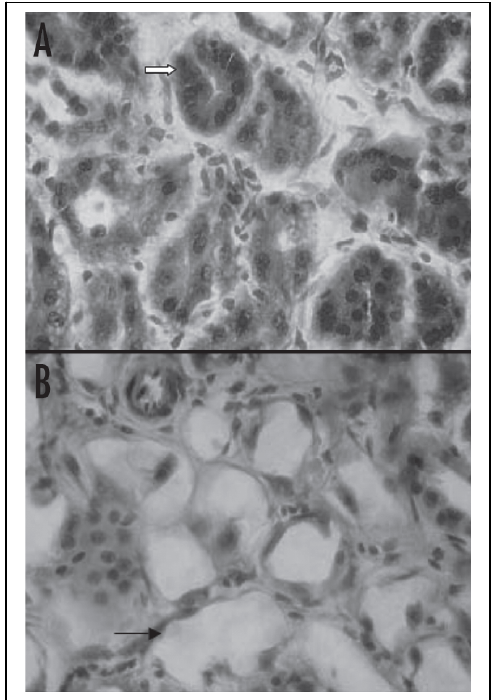
Figure 8. The normal renal structure in A is compared with radiation necrosis in B caused by 213 Bi-PAI2 at 13 weeks post-injection. Arrow in image A indicates normal tubule compared with B which shows the tubular vacuolization and dilation, a result of the toxic effect. H&E staining with magnification of × 1000